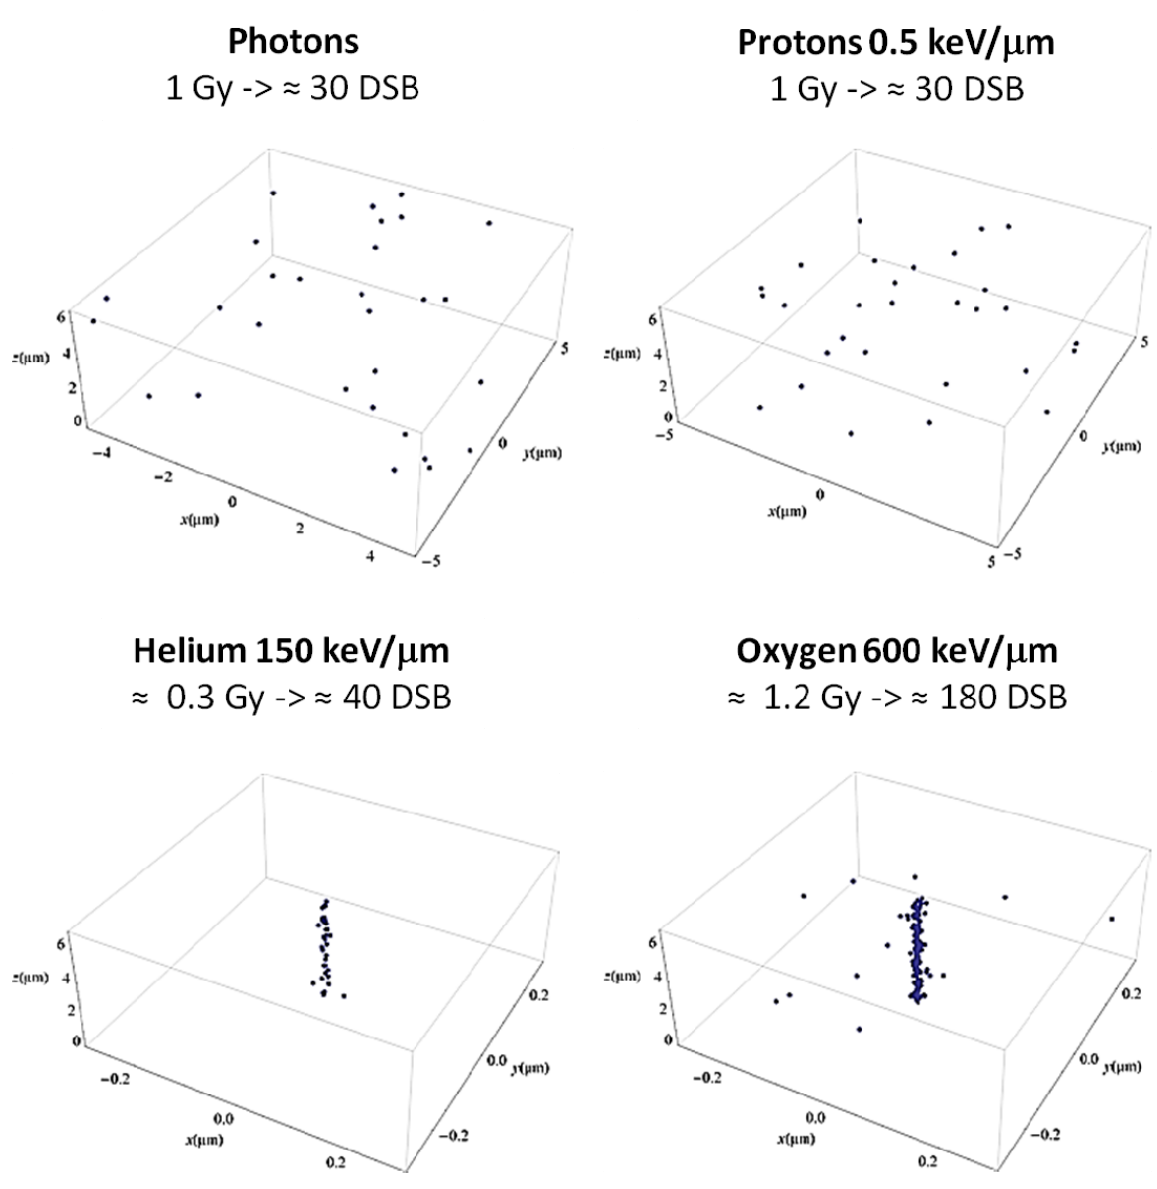
Figure 1. Simulated patterns of DSB distribution after photon and ion irradiation in a typical cell nucleus (radius of ≈ 5 μ m). Protons are shown at the typical LET assumed in the entrance channel, resulting in a photon-like distribution of lesions (sparsely ionizing radiation). Low energy alpha particles and oxygen ions are also shown as representative of the typical target fragments produced in PT. In this case, a considerable dose is released in the nucleus after a single particle traversal, and a high dose is released close to the particle track, resulting in the induction of an increased number of close-by DSB (densely ionizing radiation). The DSB distributions were calculated with the Local Effect Model (LEM) [14,15], where an amorphous track structure model is